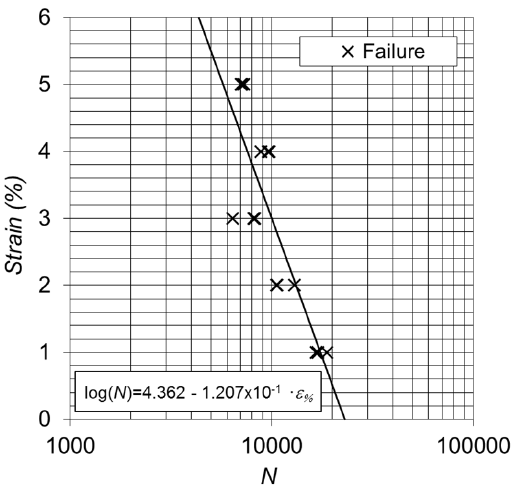
Figure 5: Evolution of the maximum stress in the wire under constant-strain